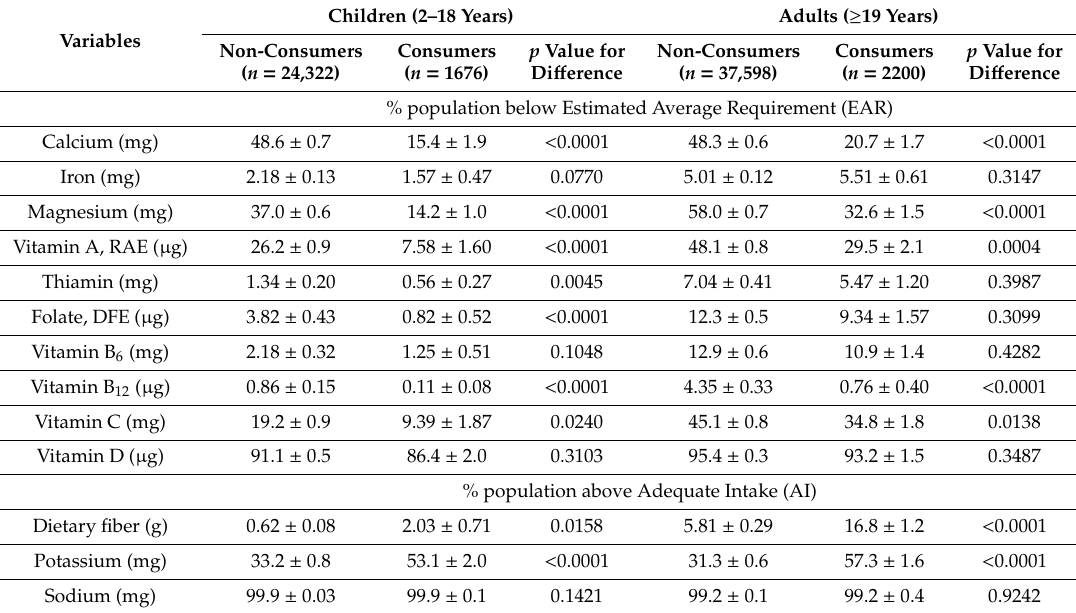
Table 3. Nutrient adequacy in children and adult yogurt consumers and non-consumers (NHANES 2001–2016, gender combined